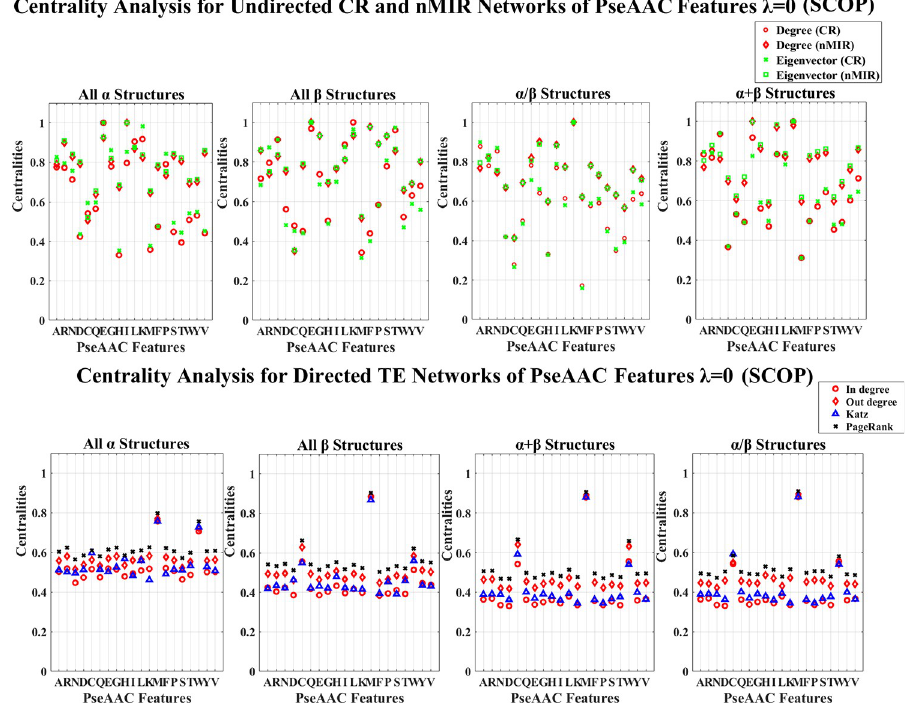
Fig 11. Centrality analysis for the networks of PseAAC features with λ = 10 (CATH). This figure shows the centrality results for the networks of PseAAC features with λ = 10 (CATH data). The normalized centralities are plotted against the features (represented by the amino acid abbreviations and the indices of the λ -tier correlations).